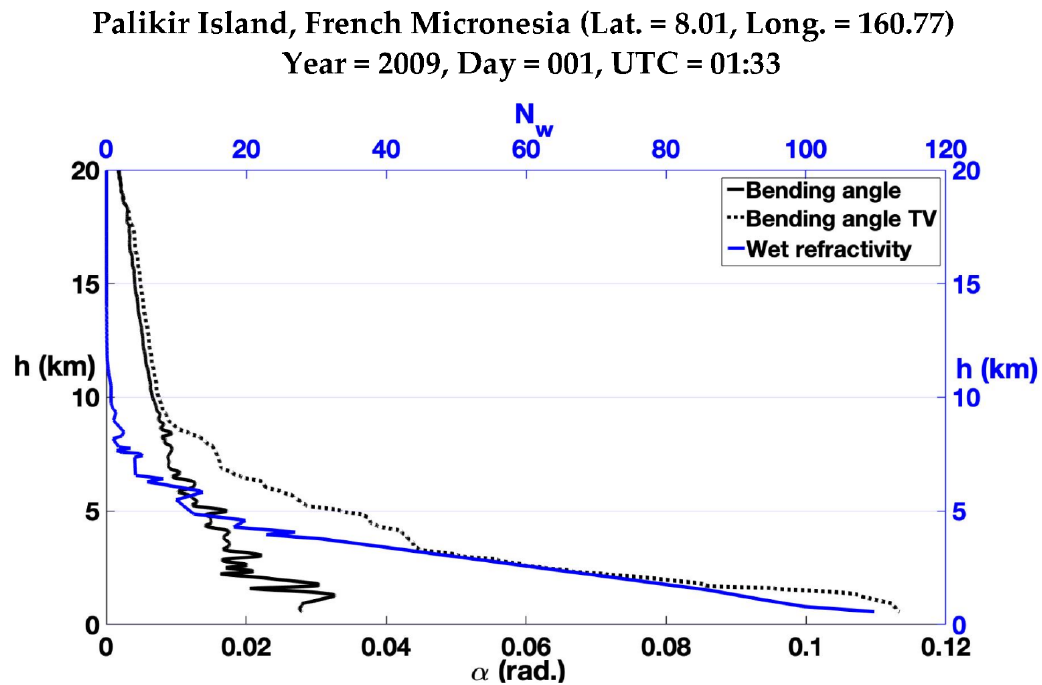
Figure 8. Bending angle γ (black), total variation of bending angle TV γ (dotted black) and wet refractivity N w (blue) profiles from the same event in Figure 6. Total variation deviates from 𝛼 in correspondence with an increase in wet refrac- tivity.